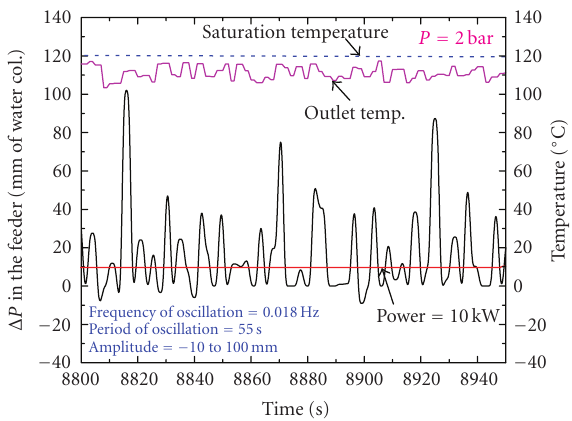
Figure 4: Typical flow instability behavior at low power under single-phase condition (power 10 kW).